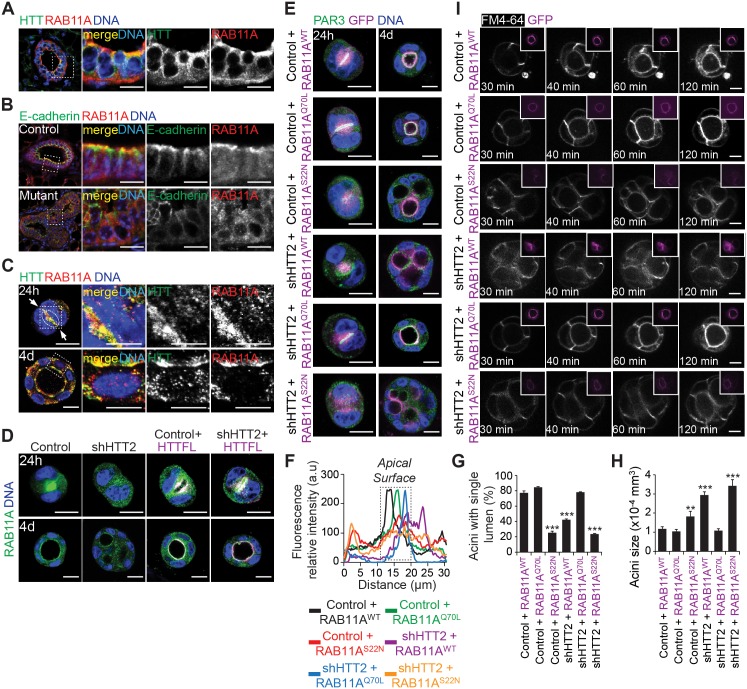
HTT colocalizes with RAB11A and regulates RAB11A activity during apical vesicular trafficking.(A) Mammary gland section stained for HTT 4C8 and RAB11A. (B) Mammary gland section stained for E-cadherin and RAB11A. (C) Twenty-four–hour and four-day MDCK 3-D cultures stained for HTT 4C8 and RAB11A. Colocalization of HTT and RAB11A is displayed in yellow (merge). (D) Twenty-four–hour and four-day MDCK 3-D cultures stained for RAB11A. HTTFL is tagged with mCherry and fluorescence is displayed in magenta and the colocalization of RAB11A and HTTFL appears in white. (E) Twenty-four–hour and four-day MDCK 3-D cultures transfected with RAB11AWT, RAB11AQ70L or RAB11AS22N, stained for PAR3. RAB11 is tagged with GFP and fluorescence is displayed in magenta. The colocalization of aPKC and RAB11A appears in white. (F) Representative line-scan analysis (relative fluorescence intensity; at least 20 cells were analyzed per condition). (G) Percentage of acini with normal lumen. (H) Quantification of acini size. (G and H) Control+RAB11AWT: n = 59 acini, Control+RAB11AQ70L: n = 54 acini, Control+RAB11AS22N: n = 66 acini, shHTT2+RAB11AWT: n = 60 acini, shHTT2+RAB11AQ70L: n = 72 acini, shHTT2+RAB11AS22N: n = 93 acini. (I) FM64-4 4-day MDCK 3-D structures were video recorded. Maximum intensity and z projections are shown. All scale bars, 10 μm. Error bars, SEM. ** p<0.01; *** p<0.001. Complete statistical analyses with number of measures are detailed in S1 Data.